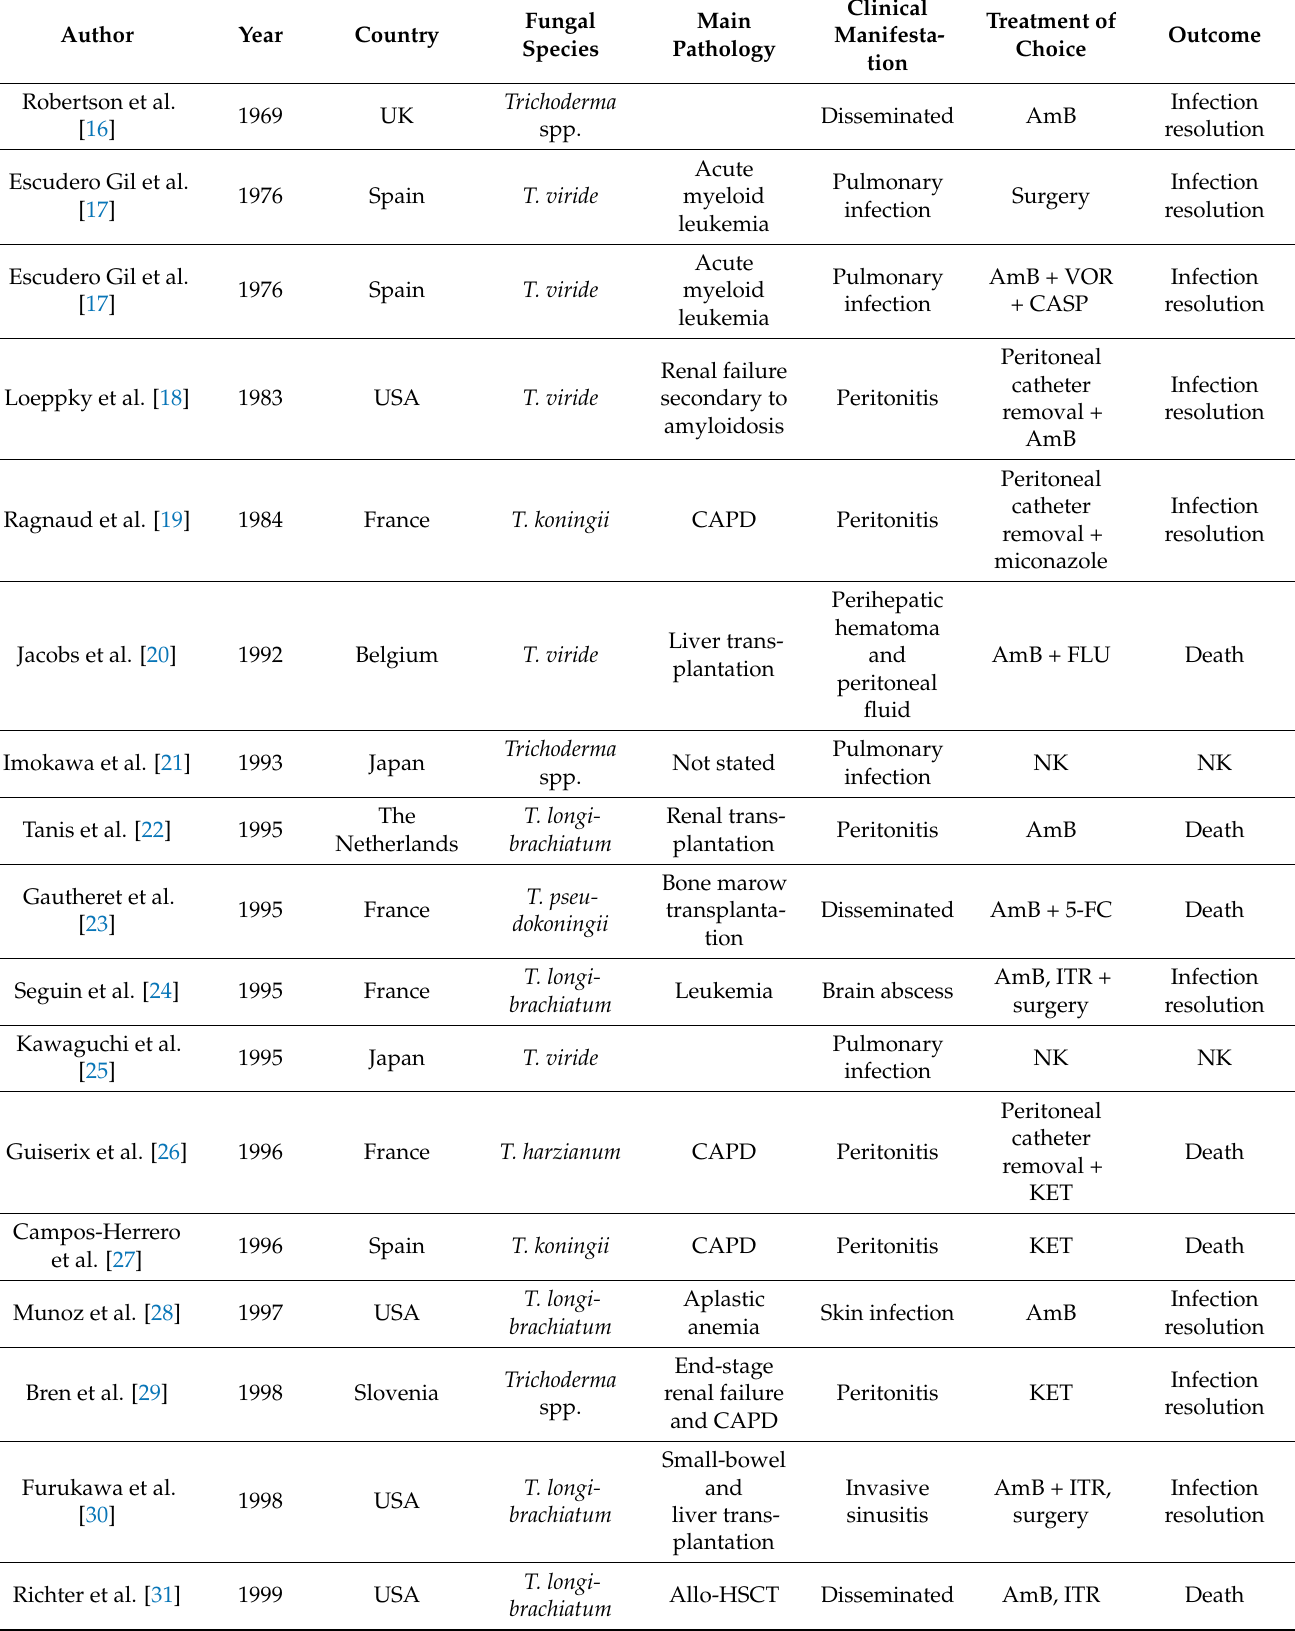
Table 1. Summary of